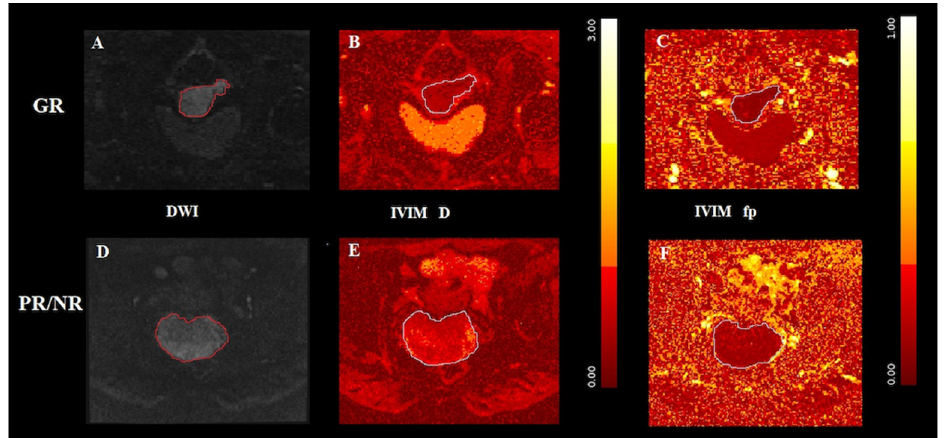
Figure 4 . ( A , D ) A cervical adenocarcinoma displayed in DWI of good responder ( A ) and poor/non- responder ( D ), respectively; ( B , E ) the D map and ( C , F ) the fp map obtained from IVIM of the good responder GR in the top row and the poor/non-responder in the bottom row, respectively. Outlines indicate the tumor region.